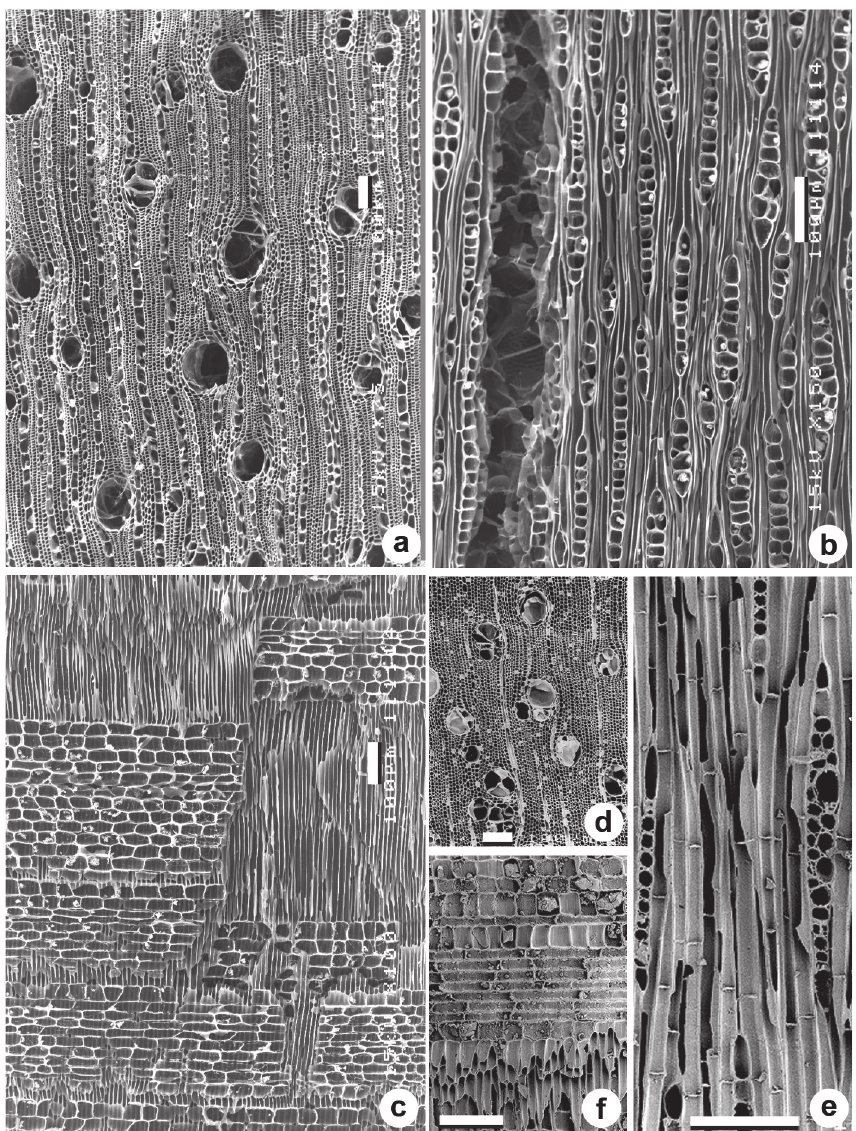
Figure 1. a-c . Anacardium occidentale (BCTw 12687). Uncoated, IBCCF/UFRJ. - d-f . Astronium lecointei (RBw 6708), platinum-coated, UM-II. - a,d : Transverse section. - b,e : Tangential section - c,f : Radial section. Bars = 100